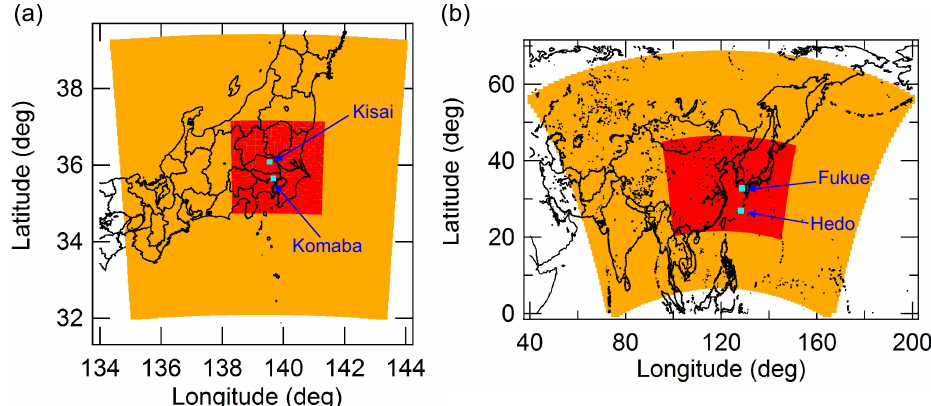
Figure 2. Simulation domains (a) in and around Tokyo during the IMPACT campaign and (b) over East Asia during the A-FORCE campaign. (a) Simulations were conducted for 17 July to 15 August 2003 (IMPACT-2) and for 23 July to 15 August 2004 (IMPACT-L) with horizontal resolutions of 27km (outer domain, orange) and 9km (inner domain, red). Light-blue squares show the locations of the measurement stations at Komaba (35.66 ◦ N, 139.67 ◦ E) and Kisai (36.08 ◦ N, 139.55 ◦ E). (b) Simulations were conducted for 21 March to 26 April 2009 with horizontal resolutions of 180km (outer domain, orange) and 60km (inner domain, red). Light-blue squares show the locations of the measurement stations at Fukue (32.75 ◦ N, 128.68 ◦ E) and Kisai (26.87 ◦ N, 128.25 ◦